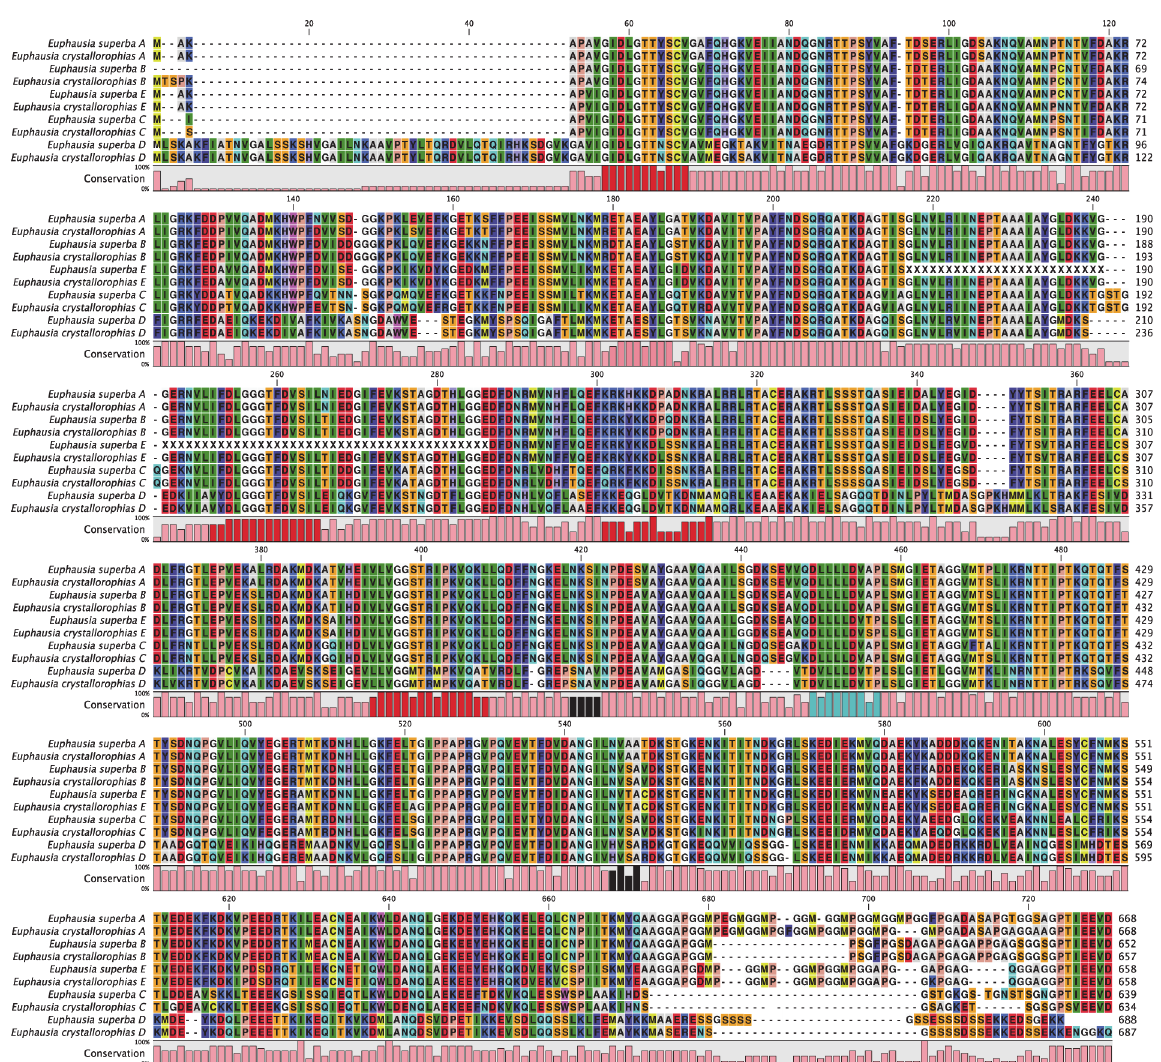
Fig 2. Alignment of five Hsp70 isoforms from E . superba and E . crystallorophias . In red: Hsp70 diagnostic motifs; in black: possible glycosylation sites; in blue: hydrophobic linker between Nucleotide Binding Domain and Substrate Binding